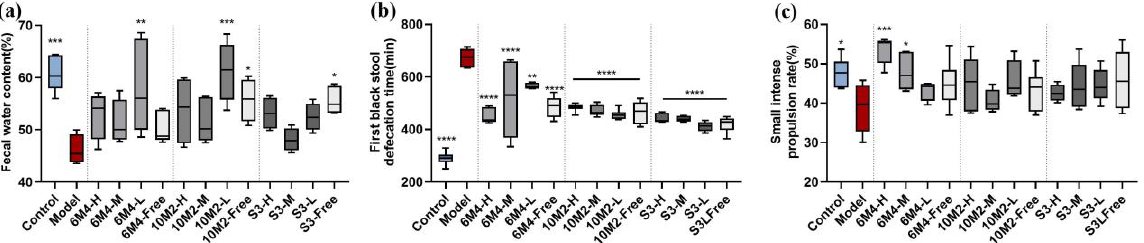
Figure 2. Apparent indicators of constipation: ( a ) fecal water content (%); ( b ) first black stool defecation time (min); ( c ) small intestine propulsion rate (%). Data are shown as mean ± SD ( n = 6). * p < 0.05, ** p < 0.01, *** p < 0.001, **** p < 0.0001, compared with the model group.